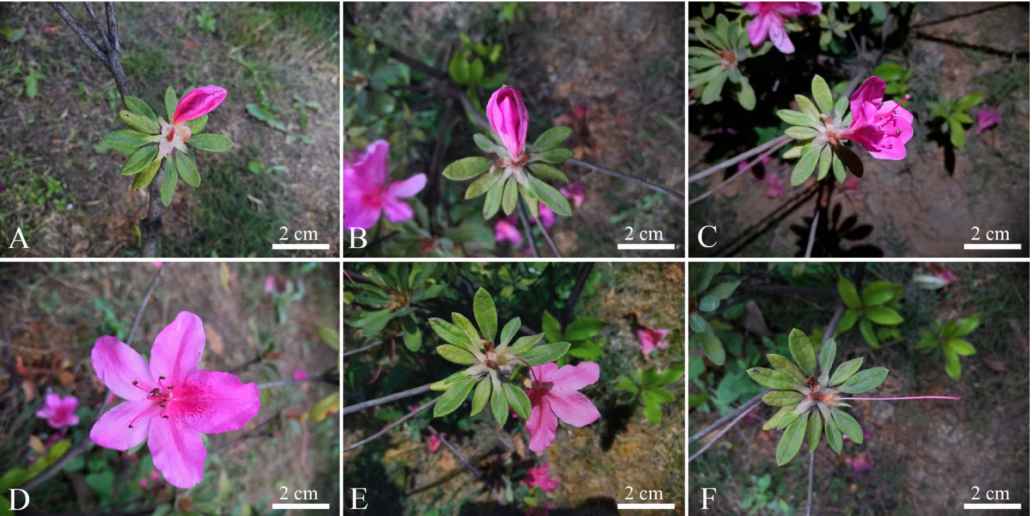
Figure 4. Opening dynamics of individual flowers. ( A ): bud period; ( B ): bud cracking period; ( C ): initial flowering period; ( D ): blooming period; ( E , F ): end of flowering period.